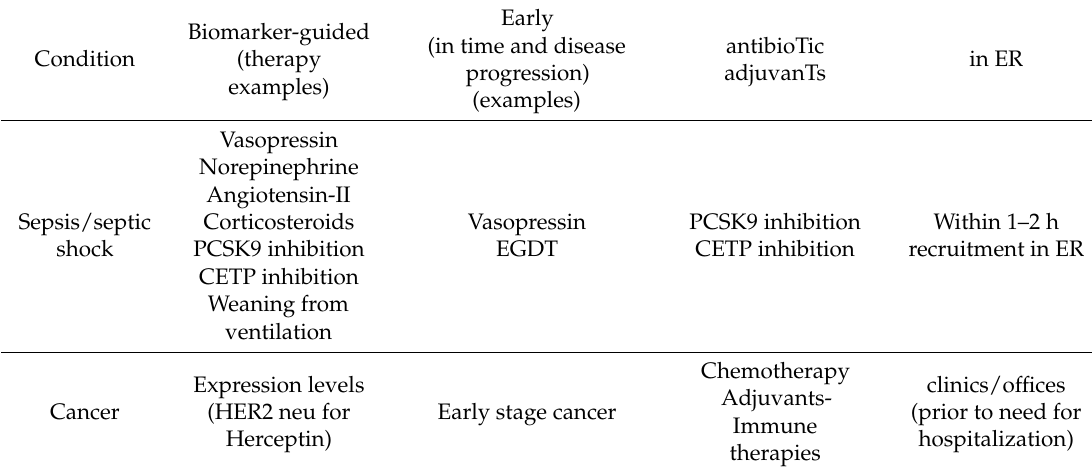
Table 1. Key features of BETTER RCTs in sepsis and septic shock compared to oncology RCTs that lead to BETTER